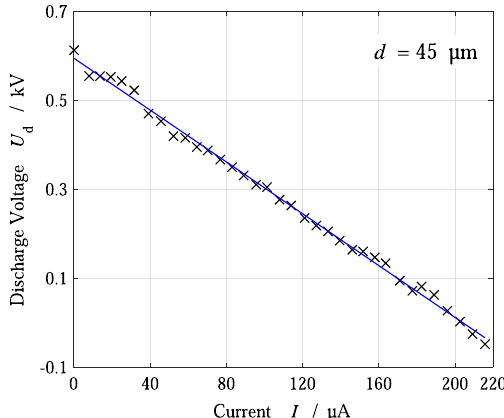
Figure 8. Variation of voltage U d with current I associated with the microstructured electrode of Figure 7. Comparison between experimental data ( (cid:4)(cid:4)(cid:4) ) and empirical model ( – ), Equation (2), with the adjusted parameters U s ’ 595 V and R d ’ (cid:2) 2.9 M X deduced from a least squares method.